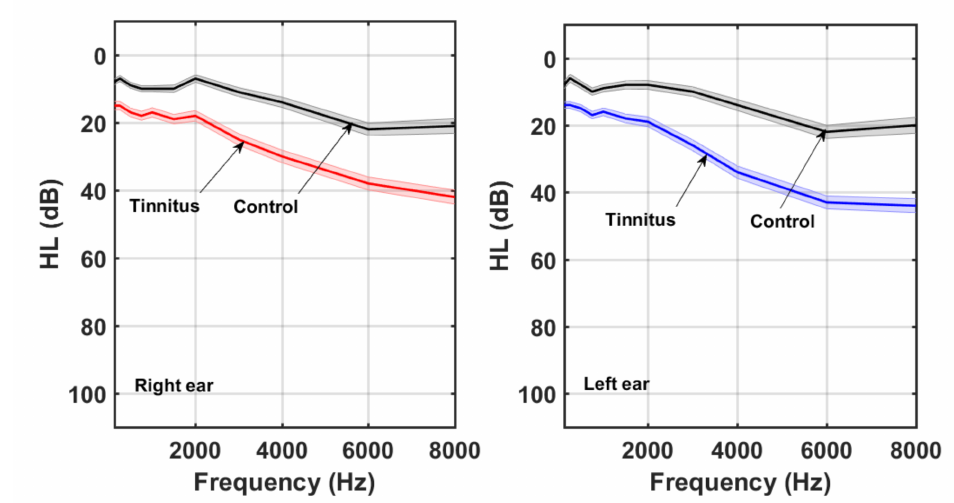
Figure 1. Right and left ear averaged HL curves for tinnitus and control participants.